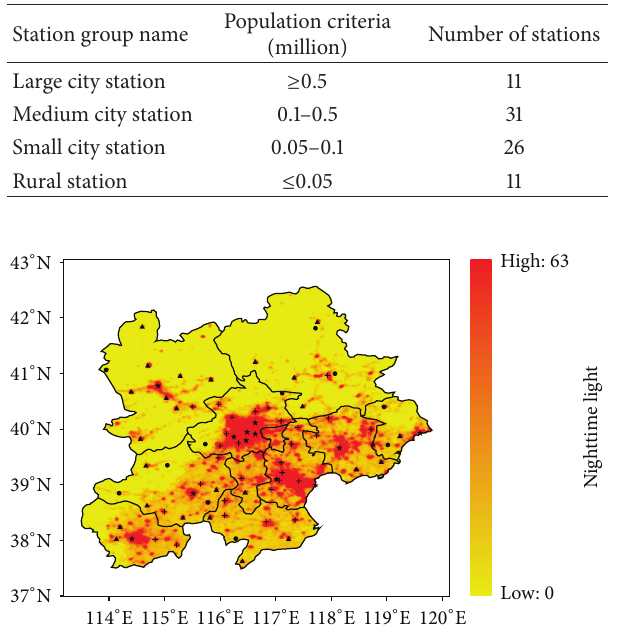
Figure 2: The distribution of the four types of stations in the JJJ area. The background is DMSP/OLS nighttime light data from 2009 ( 󳀅 large city station; + medium city station; 󳵳 small city station; ∙ rural